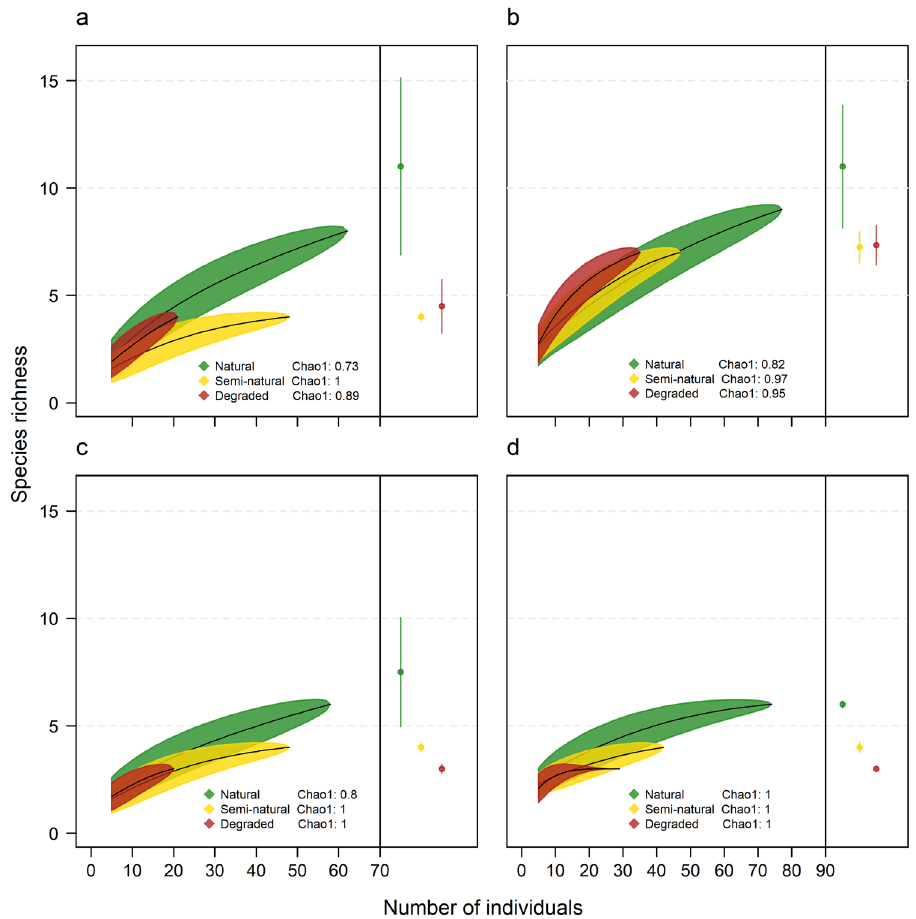
Figure 3. Bat richness with 95% confidence intervals based on individual-based rarefaction and estimated richness based on Chao1 between three levels of habitat disturbance for: ( a ) all understory species in forest habitat, ( b ) all understory species in riparian habitat, ( c ) understory phyllostomid species in forest habitat, and ( d ) understory phyllostomid species in riparian habitat. The completeness index calculated from the Chao1 estimator for each disturbance level is